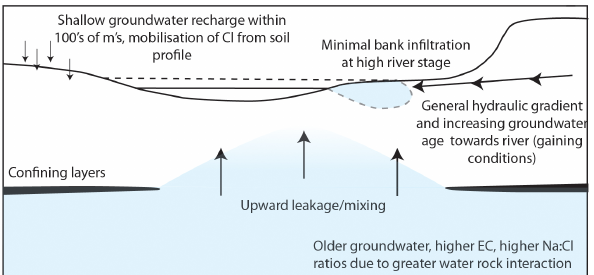
Figure 12. Schematic representation of the Tambo River and major hydrogeochemical processes at baseflow (solid line) and high-flow (dashed line) conditions. The deeper groundwater is from 15 to 20m below ground surface within the alluvial aquifer and is confined beneath the clay